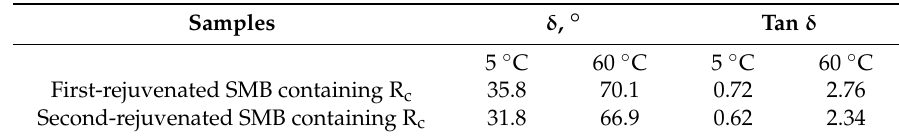
Table 3. Loss tangent of first- and second-rejuvenated SMB containing 10%FCC/3%AGE/1% MDI (R c ) at 5 ◦ C and 60 ◦